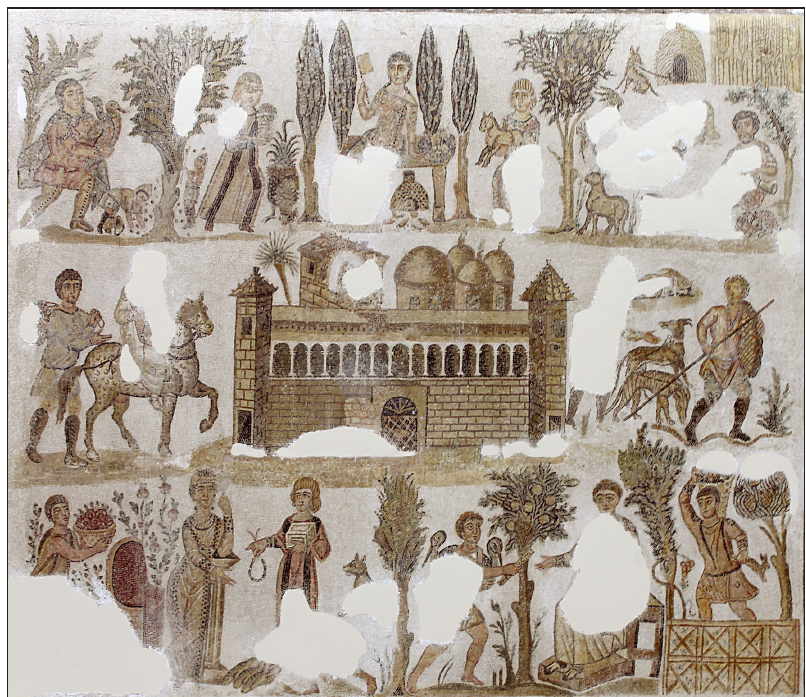
Figure 6: The Estate of Dominus Julius, Bardo Museum. (Photo: Boyd Dwyer, licensed under Creative Commons Attribution-Share Alike 2.0 Generic